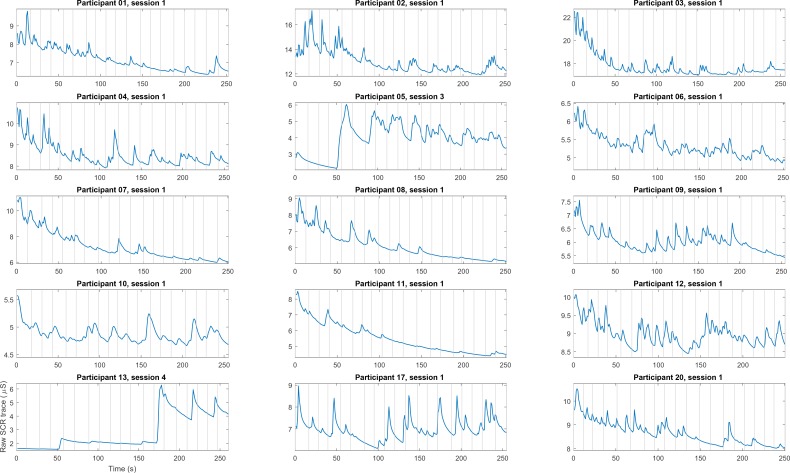
Experiment 1: raw skin conductance traces, where vertical lines are beginning of each trial when cue display starts (n = 15, excluded participants not shown, showing first non-excluded session from all participant).